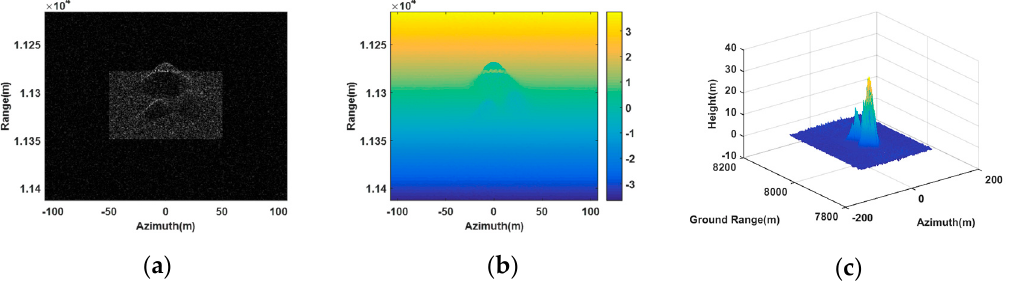
Figure 6. 3D deceptive scene generation simulation based on three transponders. ( a ) SAR image in the antenna A 1 . ( b ) Absolute interferogram after unwrapped. ( c ) DEM of the false scene.